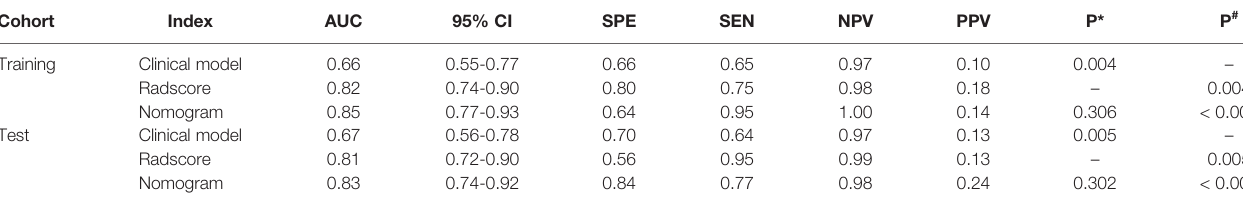
TABLE 2 | Diagnostic performance of clinical model, radscore, and radiomics nomogram in the training and test